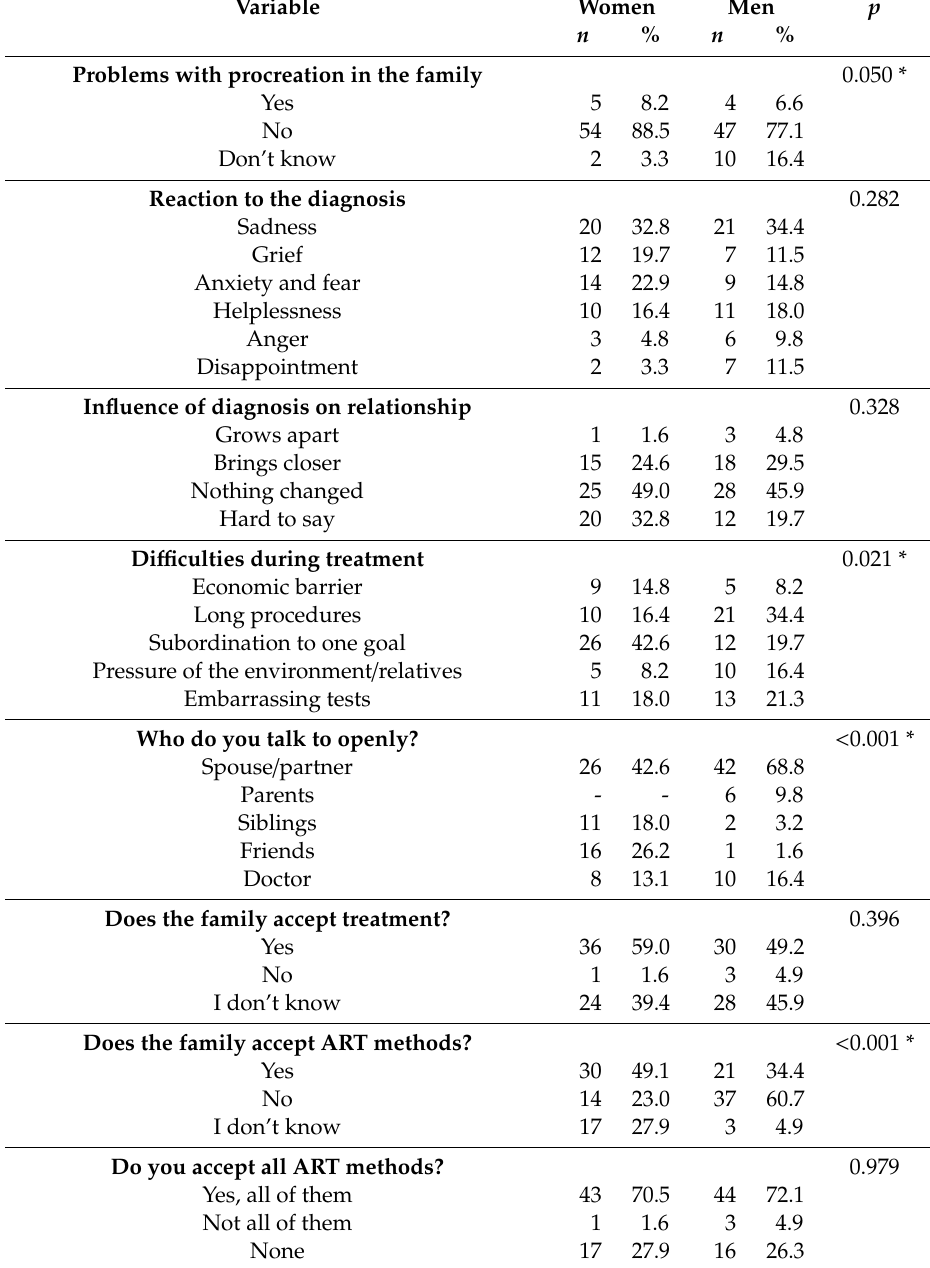
Table 3. The approach of men and women to the